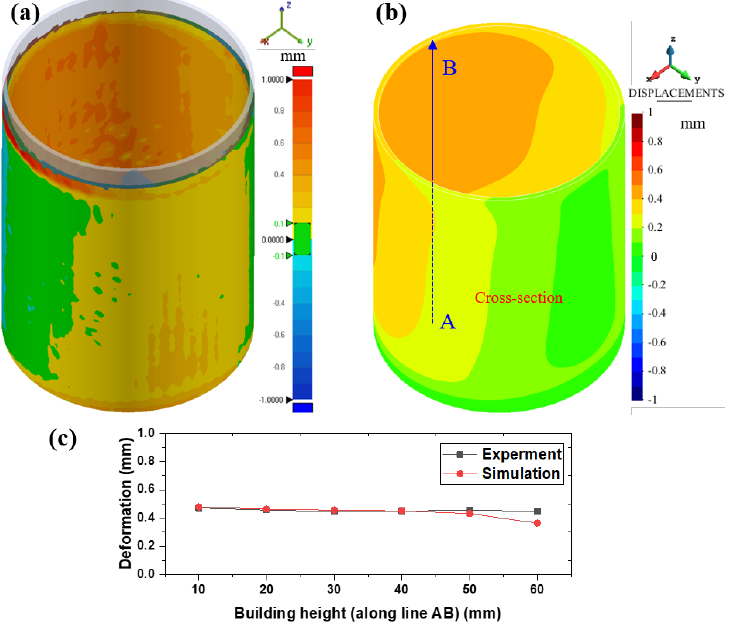
Figure 13. Comparison between the ( a ) experimental and ( b ) simulated displacement distributions of the hollow cylindrical part. ( c ) The deformation distribution along the line AB located at the center of the inner surfaces of the build.